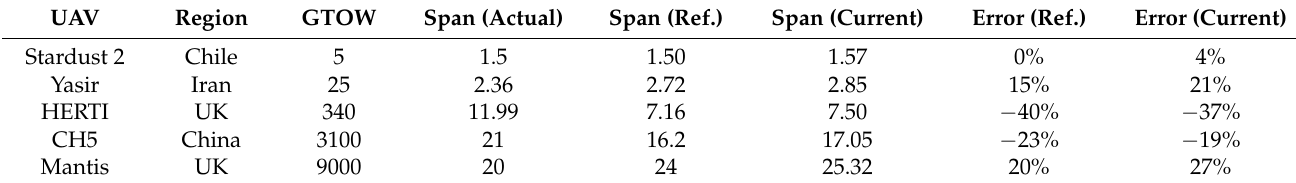
Table 4. Indicative results for UAVs of different NATO categories (“Current”) and comparison with the actual values (“Actual”) and the reference literature [24]